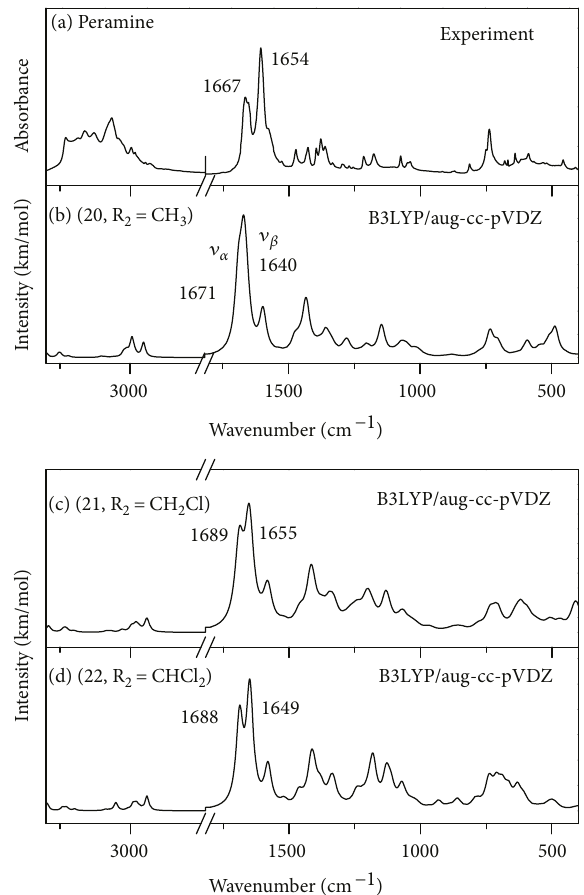
Figure 4: Experimental (a, b) and calculated (c, d) IR spectra (B3LYP/aug-cc-pVDZ level of theory) of peramine 20 (R 21 (R =CH Cl), and 22 (R =CHCl2) according to Scheme 2 2 2